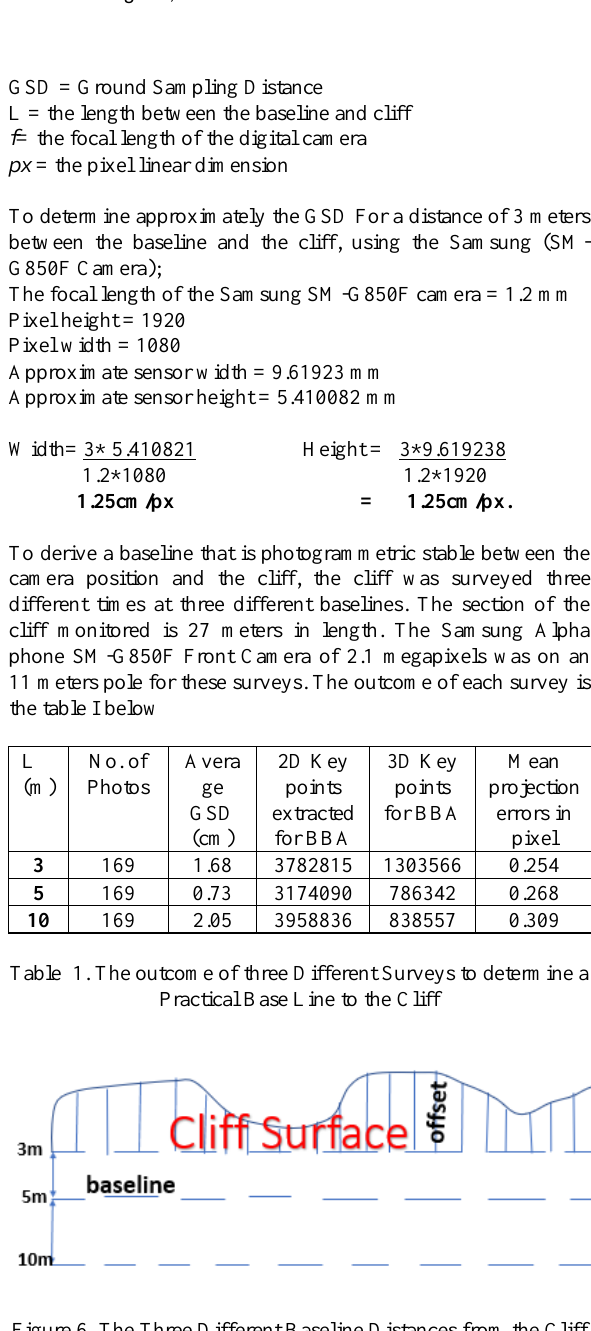
Figure 6. The Three Different Baseline Distances from the